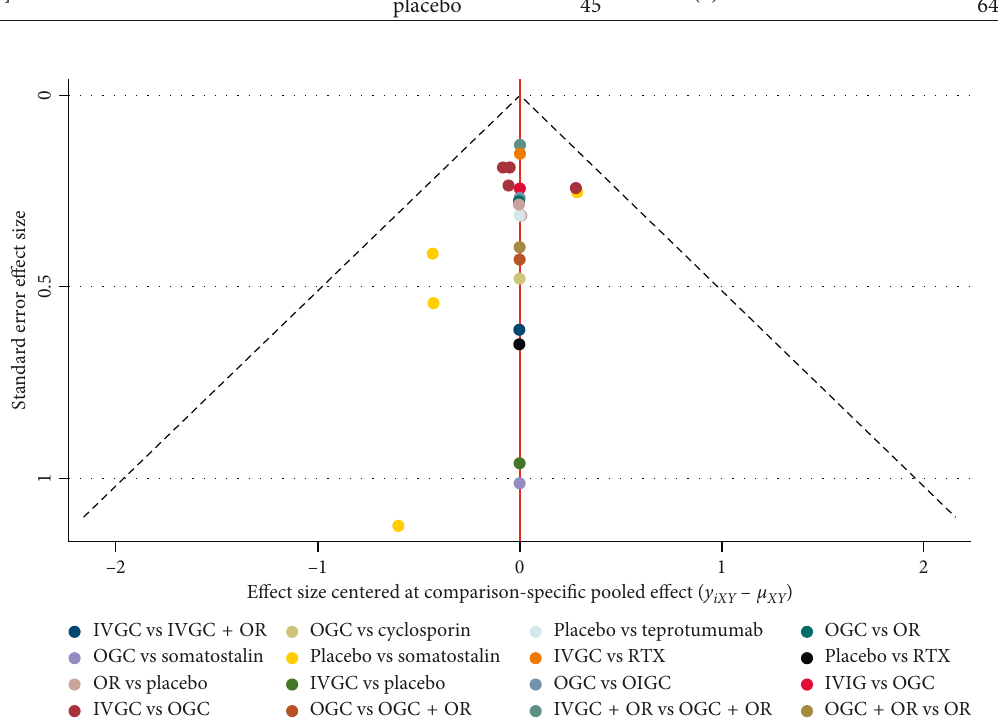
Figure 2: Funnel plot for the network